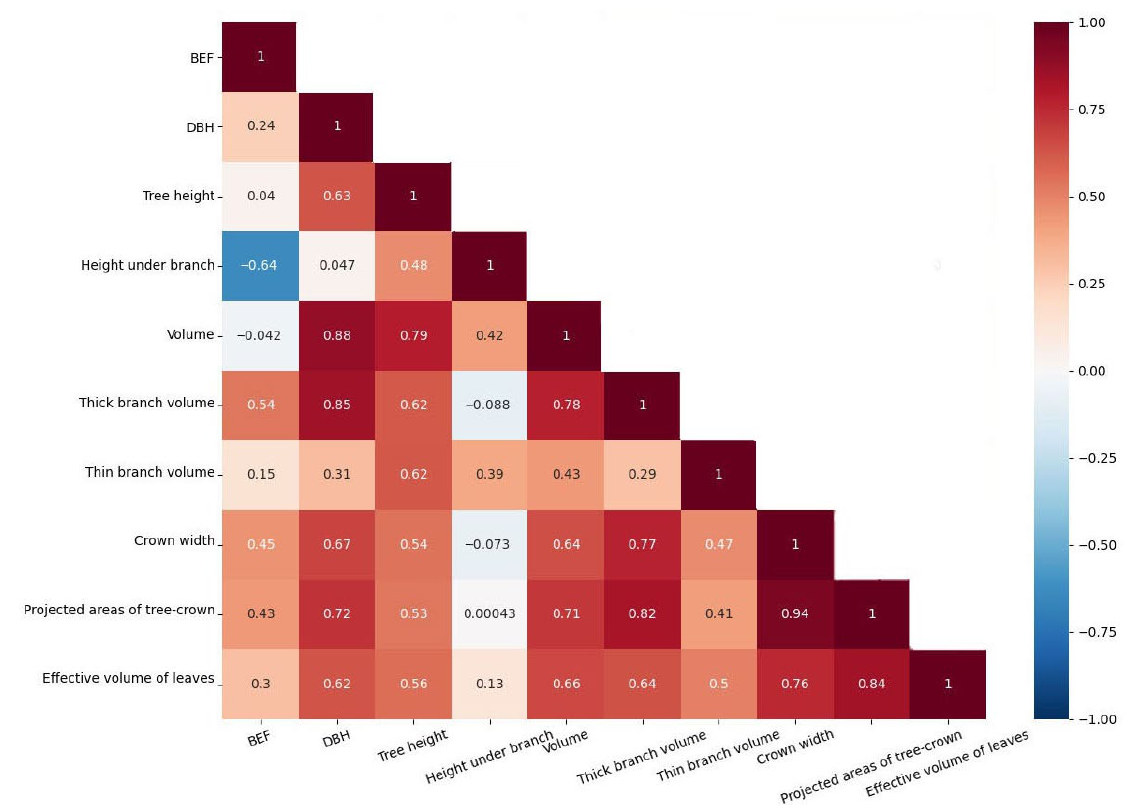
Figure 11. Heat map of correlation between BEF and tree measurement factors.